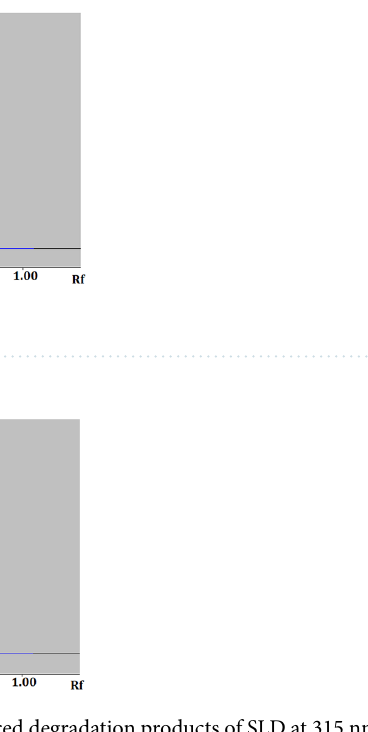
Figure 3. Chromatogram of hydrogen peroxide-induced degradation products of SLD at 315 nm